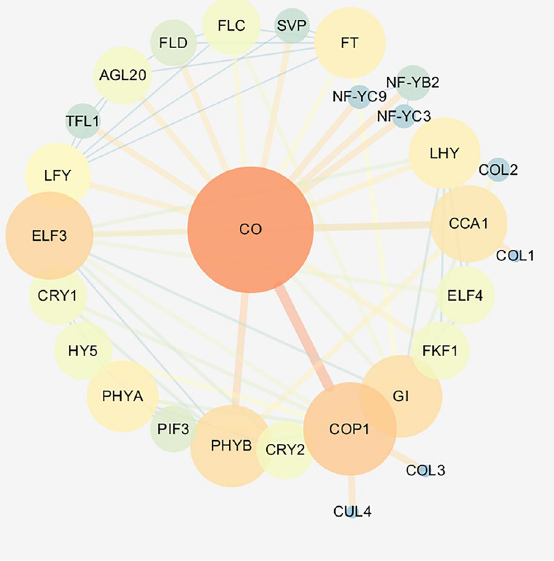
Figure 8. Predicted interaction network of PlCO. The circles represent proteins; the lines represent interaction relationships; the colors represent the